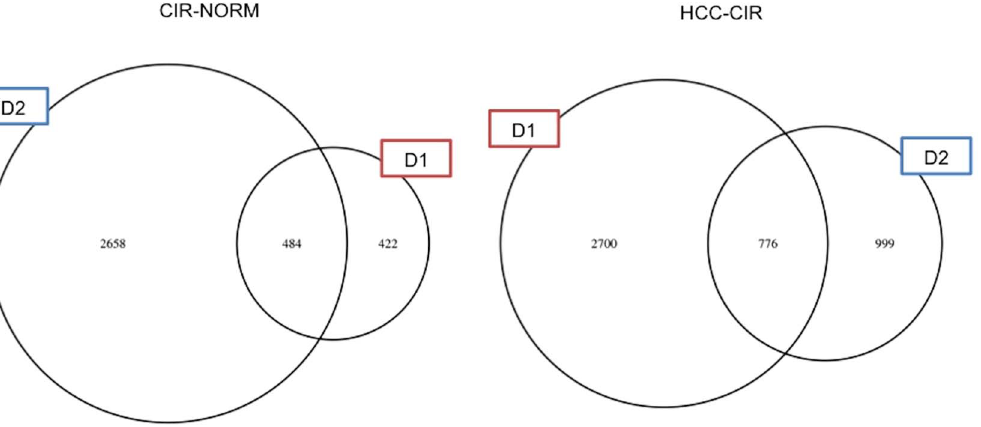
Figure 4. Venn diagram of the common DE genes for CIR-NORM and HCC-CIR contrasts. The number of DE genes is shown for each dataset (D1 and D2) for the two contrasts. The CIR-NORM and HCC-CIR contrasts show respectively 484 and 776 common DE genes between D1 and D2. The number of DE genes depends on the platform used for the microarray